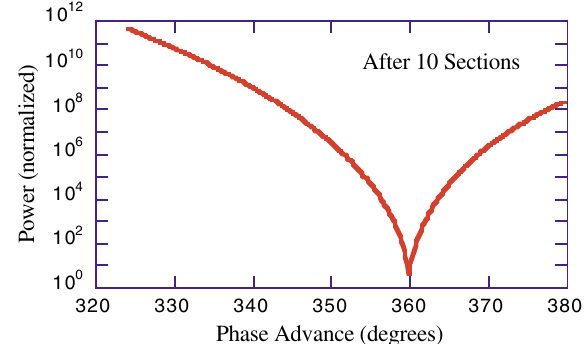
FIG. 1. (Color) Cavity dipole mode power as a function of phase